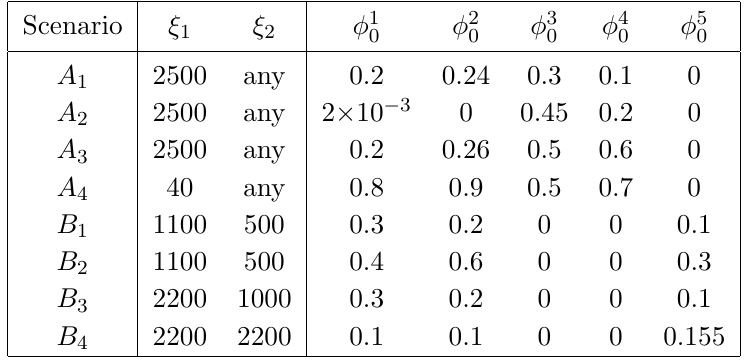
= 65 in the scenarios of type A (see e